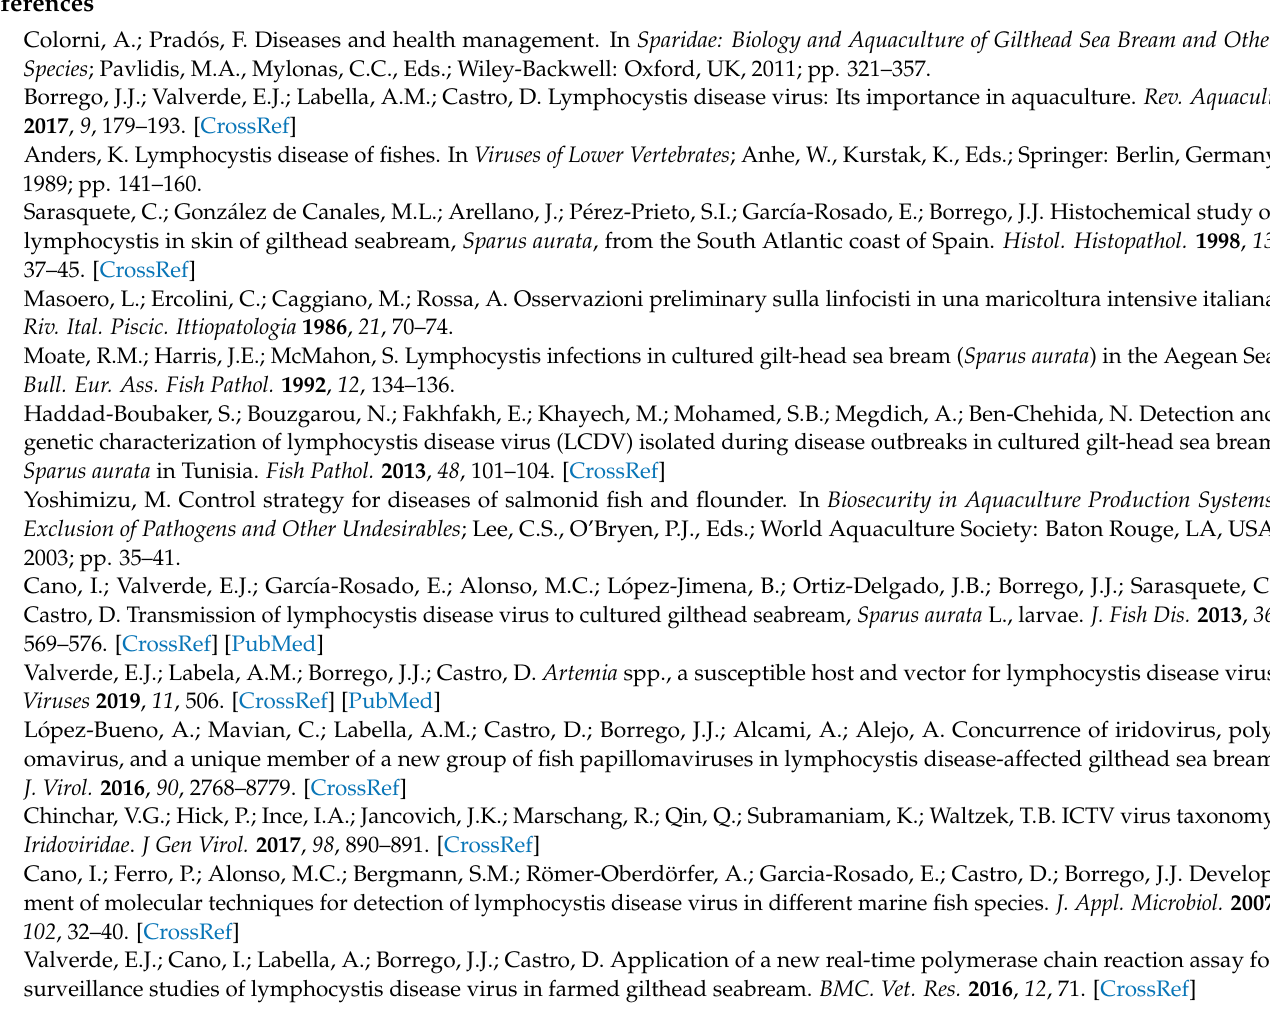
Inter-Assay Variation